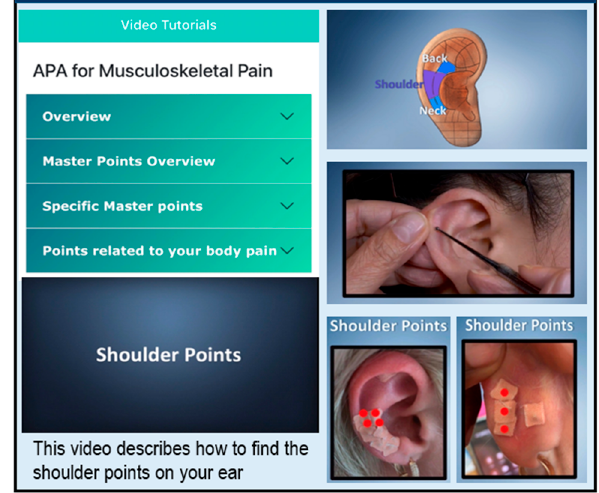
Figure 1. App for chronic musculoskeletal